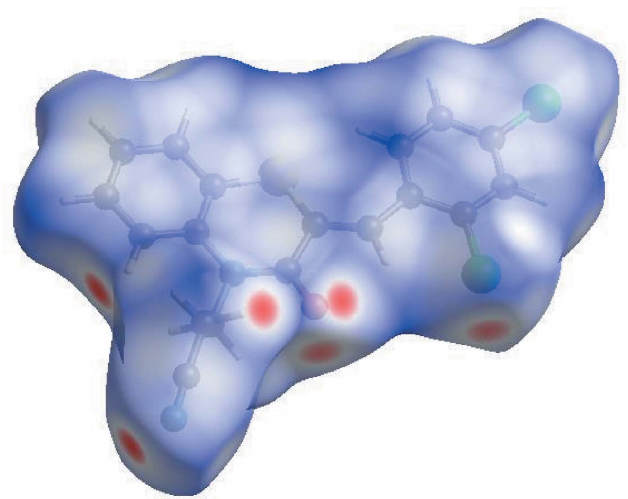
Figure 4 View of the three-dimensional Hirshfeld surface of the title compound plotted over d norm in the range (cid:3) 0.2386 to 1.2893